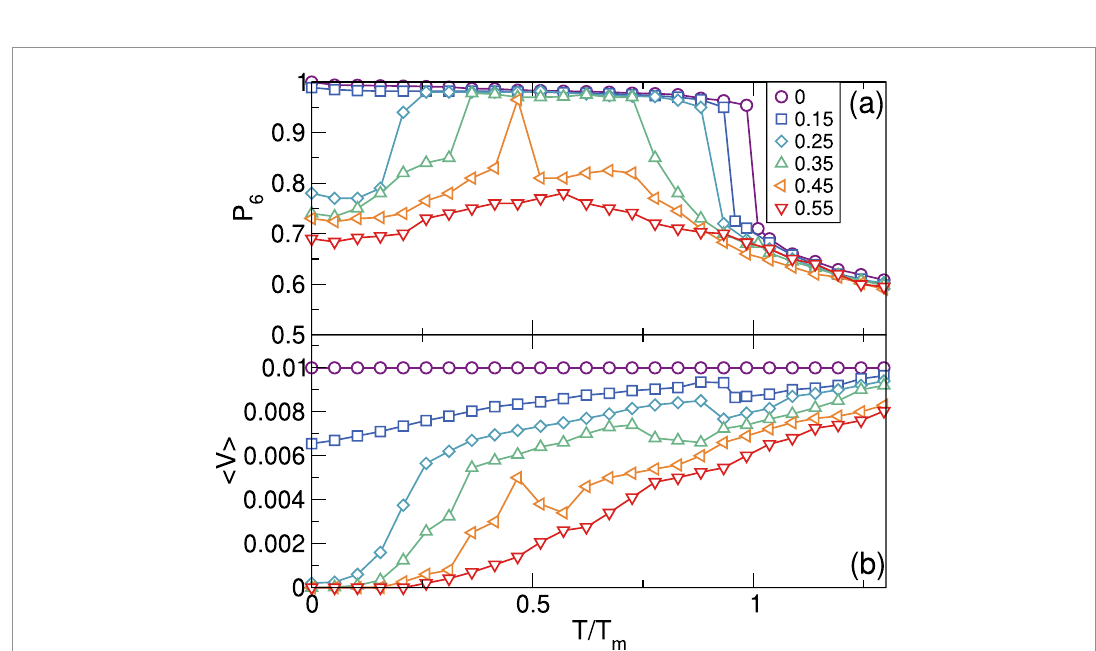
Figure7. (a) P 6 vs T / T m for the system in figure 4 at fixed σ = 0.12 for n p = 0, 0.15, 0.25, 0.35, 0.45, and 0.55, from top to bottom. (b) The corresponding ⟨ V ⟩ vs T / T m under a drive of F D = 0 . 01 showing a drop in velocity across the thermal melting